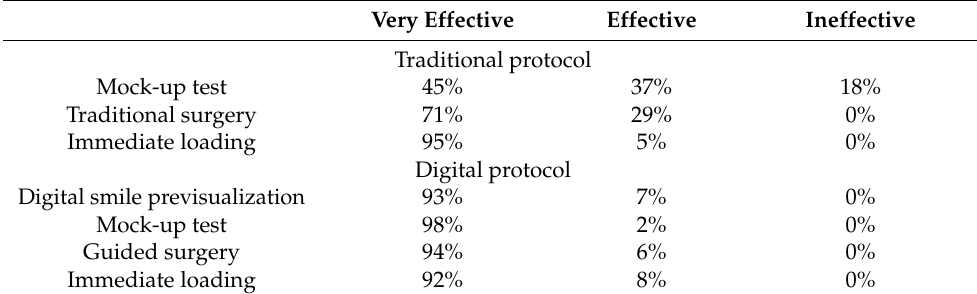
Table 5. Patients’